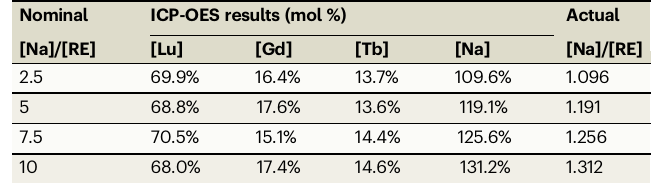
Table 1 | Nominal and ICP-OES results of the NaLuF 4 : Gd/Tb NPs prepared with different [Na]/[RE]. [RE] = [Lu] + [Gd] + [Tb] = 100% Nominal ICP-OES results (mol %)